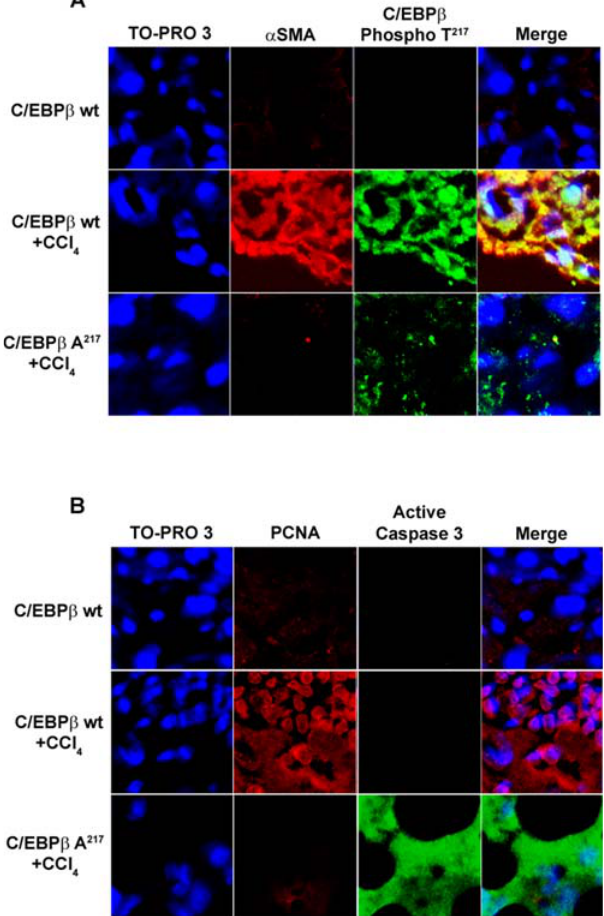
Figure 4. Mice expressing the RSK-inhibitory C/EBP b -Ala217 trans- gene are refractory to hepatic stellate cell activation and prolifer- ation. Mice received CCl 4 or mineral oil injections for 12 weeks as described in Materials and methods. A. Activated stellate cells, identified by confocal microscopy for a -smooth muscle actin ( a -SMA; red), displayed C/EBP b -PhosphoThr217 (green) in livers of C/EBP b + / + [wt], but not C/EBP b -Ala217, mice treated with CCl 4 . Colocalization of a - SMA and C/EBP b -PhosphoThr217 is shown in yellow (merge). Nuclei are identified with TO-PRO-3 (blue). Only background staining was observed when omitting the first antibody. B. Proliferating cell nuclear antigen (PCNA; red) was present in activated stellate cells only in livers of C/EBP b + / + [wt] mice treated with CCl 4 , while active caspase 3 (green) was found in HSC only in livers of C/EBP b -Ala217 mice treated with CCl 4 . Nuclei are identified with TO-PRO-3 (blue).